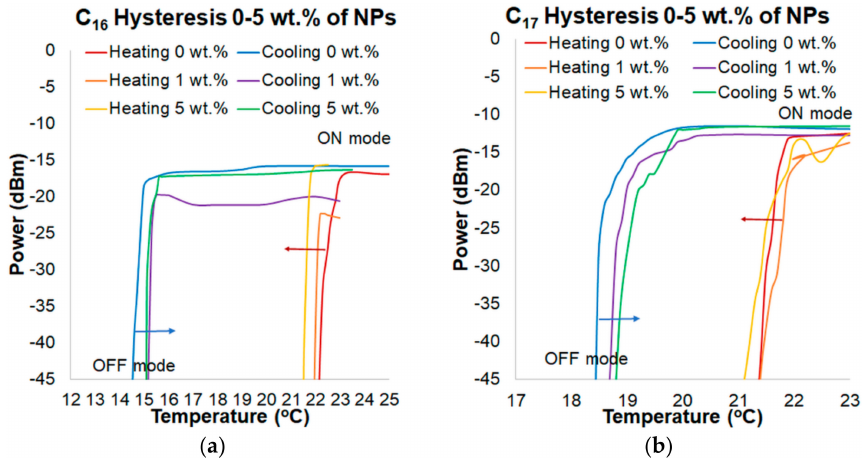
Figure 11. Hysteresis of power changing depending on temperature for a wavelength of 810 nm for: ( a ) C 16 with pure alkane and alkane with doping ratio of 1 wt.% and 5 wt.% of ZnS:Mn NPs and ( b ) C 17 with pure alkane and alkane with doping ratio of 1 wt.% and 5 wt.% of ZnS:Mn